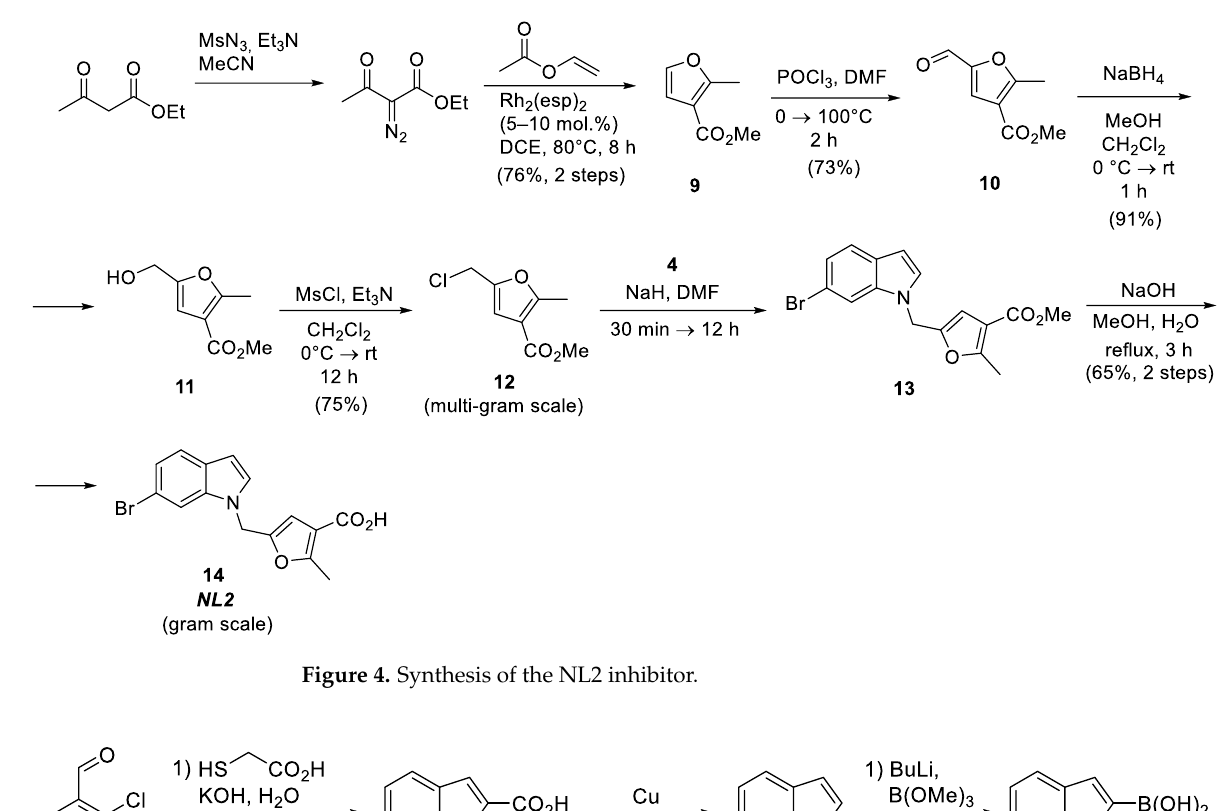
Figure 4. Synthesis of the NL2 inhibitor.